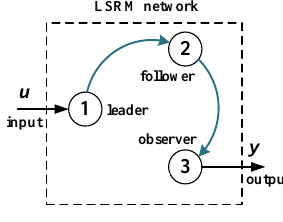
Figure 2. LSRMs leader–follower–observer network.